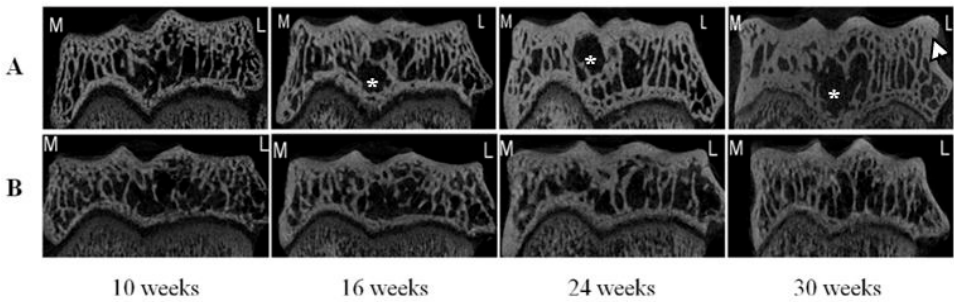
Figure 2. Frontal sections of micro-CT images of right tibial epiphysis of DH ( A ) and BS2 ( B ) at four time points. The images show the SbpTh and Tb morphometry changes on the medial (M) and the lateral sides (L) of the tibial epiphysis. Subchondral bone cyst (*) and osteophyte (arrow head) are seen in some of the images.